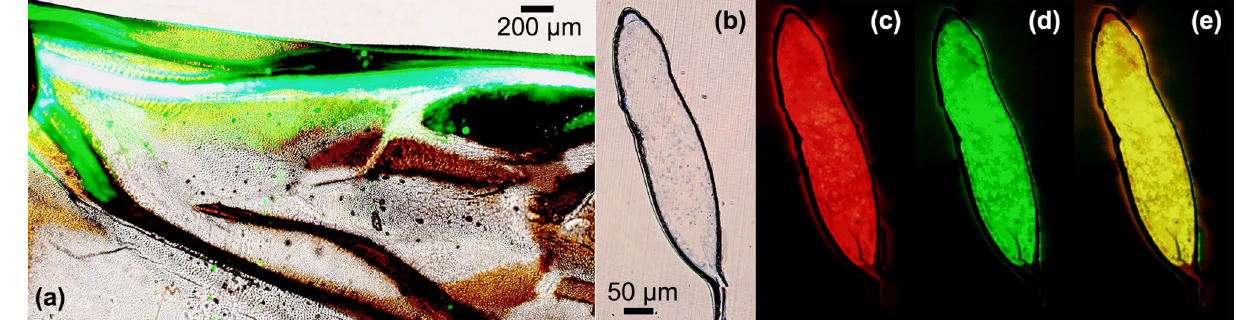
Figure 2. ( a ) Hemolymph flowing in the veins. Scale bar: 200 μm. ( b ) Cross section of the pst. ( c , d ) The pst under two fluorescence channels (excitation wavelengths of 423–476 nm and 595–677 nm). Scale bar: 50 μm. ( e ) Composite image of c and d. Scale bar: 50 μm. Position